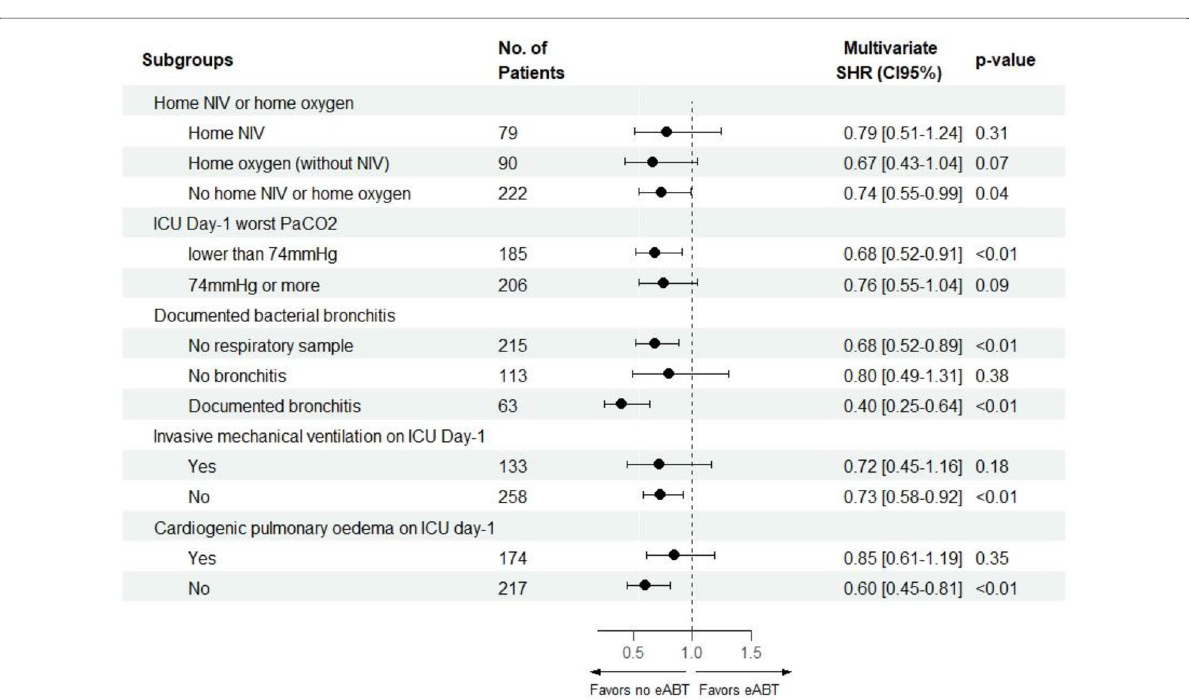
Fig. 4 Sensitivity analysis of the SHR of eABT in subgroups of patients assessed by modelling the probability of being successfully weaned from mechanical ventilation using multivariate competing risk regression. eABT was the first line of antibiotic therapy introduced during the first 24 h of ICU admission. Documented bacterial bronchitis was defined as bacterial documentation on respiratory sample performed between 48 h before ICU admission and the end of ICU day-1. Seventy-four Torr was the median value of ICU Day-1 worst PaCO2. SHR less than 1 indicates a lower probability of being successfully weaned from mechanical ventilation, accounting for the competing risk of death. SHR subdistribution